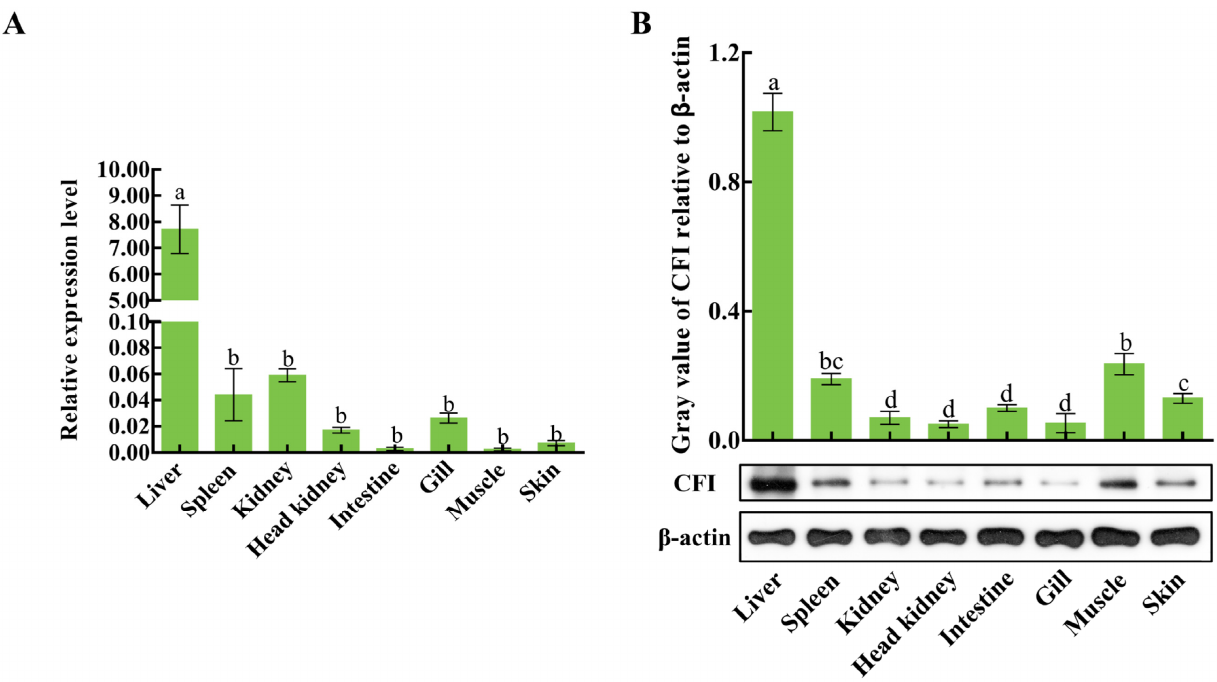
Figure 7. The mRNA and protein expressions of CiCFI in various tissues of grass carps. Letters a, b, c and d indicate significant differences among various tissues ( p < 0.05). ( A ) The mRNA expressions of CiCFI in various tissues of grass carps. ( B ) The protein expressions of CiCFI in various tissues of grass carps.